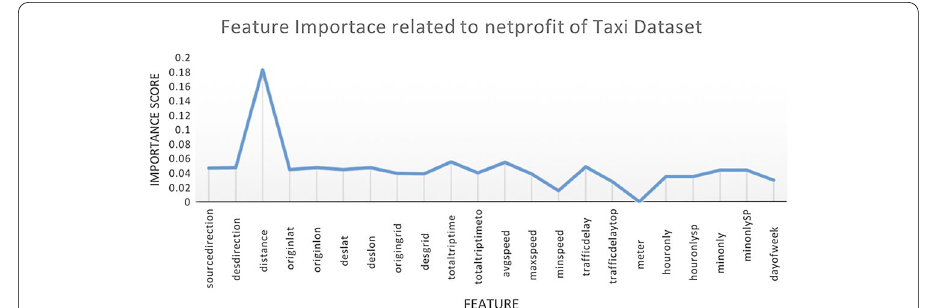
Fig. 13 Feature importance related to net-profit